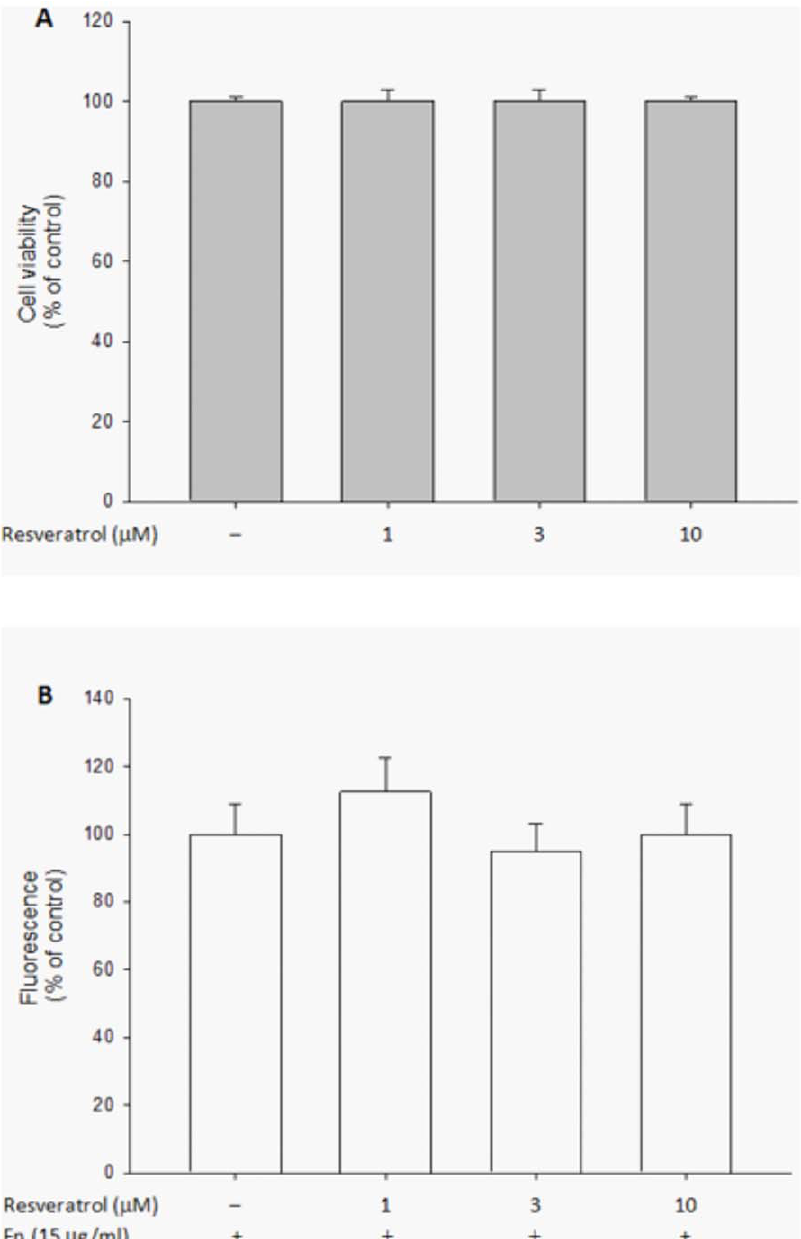
Figure 3. Viability and cell adhesion of ARPE19 cells was not influenced by resveratrol. The cells were treated with different concentrations of resveratrol for 24 hours after being starved for 24 hours. Cell viability was determined by MTT assay (A). BCECF-labeled cells were treated with DMSO or resveratrol for 30 minutes. They were then seeded and allowed to adhere on plates with precoated fibronectin (fn) (15 m g/ml) at 37 u C for 1 hour. Fluorescence was measured using excitation and emission wavelength of 485 and 535 nm, respectively (B). The results are expressed as percentage of control and represent the mean 6 standard errors (SE) of four independent experiments. doi:10.1371/journal.pone.0056819.g003 was inhibited by 10 m M of resveratrol (Figure 2C). These Figure 2A shows that significant ARPE19 cell migration on fibronectin was observed in the absence of PDGF-BB, with about observations indicate that resveratrol is effective in the prevention 20 migrated cells found in HPF, suggesting that fibronectin is a of PDGF-BB-induced ARPE19 cell migration. ‘chemoattractant’ for ARPE19 cells. PDGF-BB stimulated ARPE19 cell migration to about two folds over that elicited by Resveratrol showed no cytotoxicity on ARPE19 cells fibronectin alone. However, resveratrol abolished the PDGF-BB- To exclude the possibility that resveratrol affects ARPE19 cell induced ARPE19 cell migration on fibronectin (Figure 2B). migration through its effects on cell viability, cell viability assays Quantitative analysis indicates that nearly 100% of migration were performed. As shown in Figure 3A, resveratrol treatments (1,